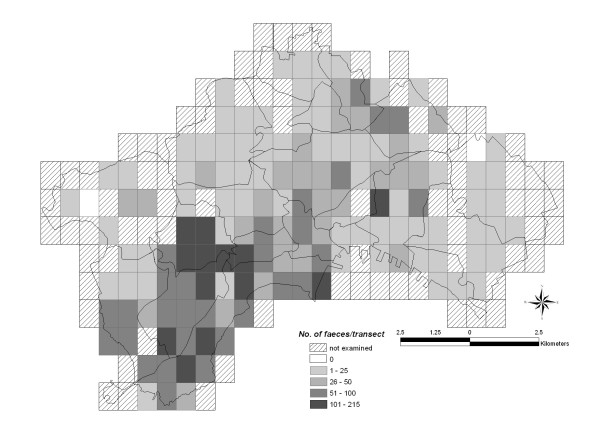
Occurrence of canine faecalization in the city of Naples, Italy, February–May, 2005. Faeces counts on regular grid of 1 km × 700 m (faeces/transect).